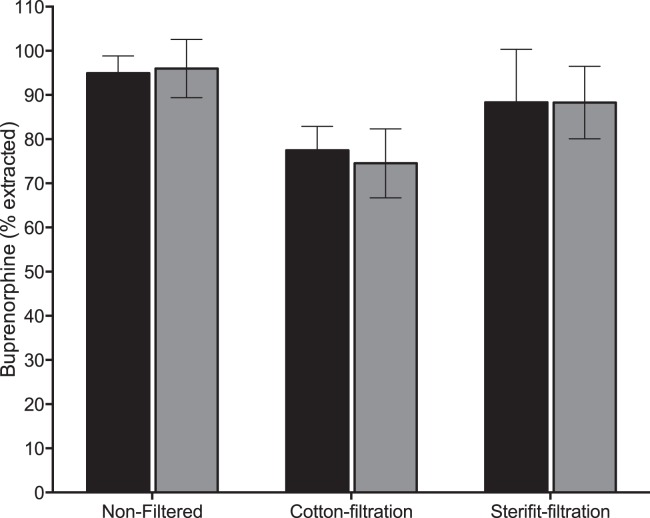
Extractibility of buprenorphine from sublingual tablets.One tablet of buprenorphine 8 mg (Subutex or generic) was diluted in 1 ml of sterile water. Drug concentration was monitored with chromatographic method before filtration or after cotton-filtration or Sterifilt-filtration for the Subutex or its generic. The volume of liquid obtained after filtration was assessed by weight difference between the vacuous syringe and full syringe. The concentration was measured after dilution of 1/10 000 in sterile water. The concentration value was transformed in percentage of the nominal dosage (8 mg).